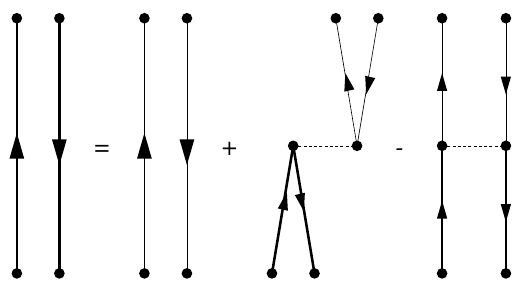
Figure 4. Graphical representation of the two-body Green function in